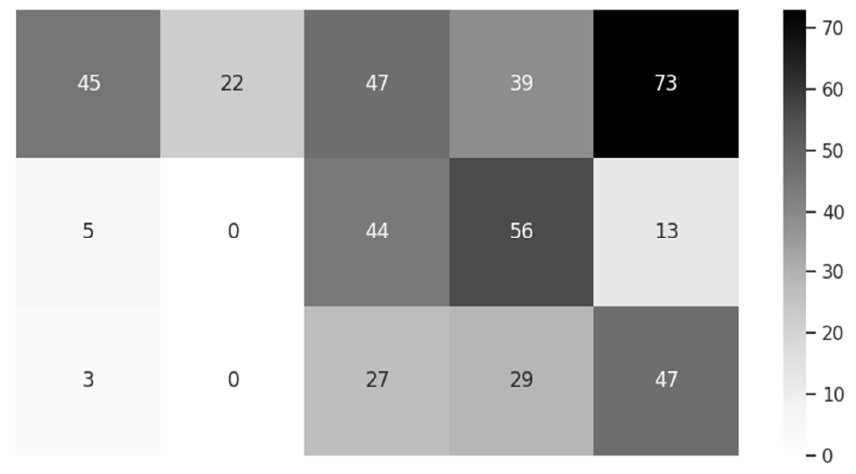
J. Sens. Actuator Netw. 2021 , 10 , x FOR PEER REVIEW Figure 16. The heatmap of rest time (minutes) in nightly groupings (user1). Figure 16. The heatmap of rest time (minutes) in nightly groupings (user1).